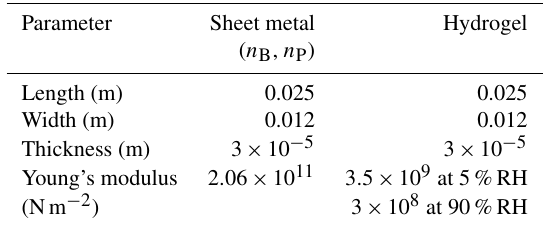
so that Eq. (18) becomes Table 1. Material and geometry parameters of the beam-like sen- sor switch with switching hysteresis (DIN EN 10270-1, 2012; Bell- mann,